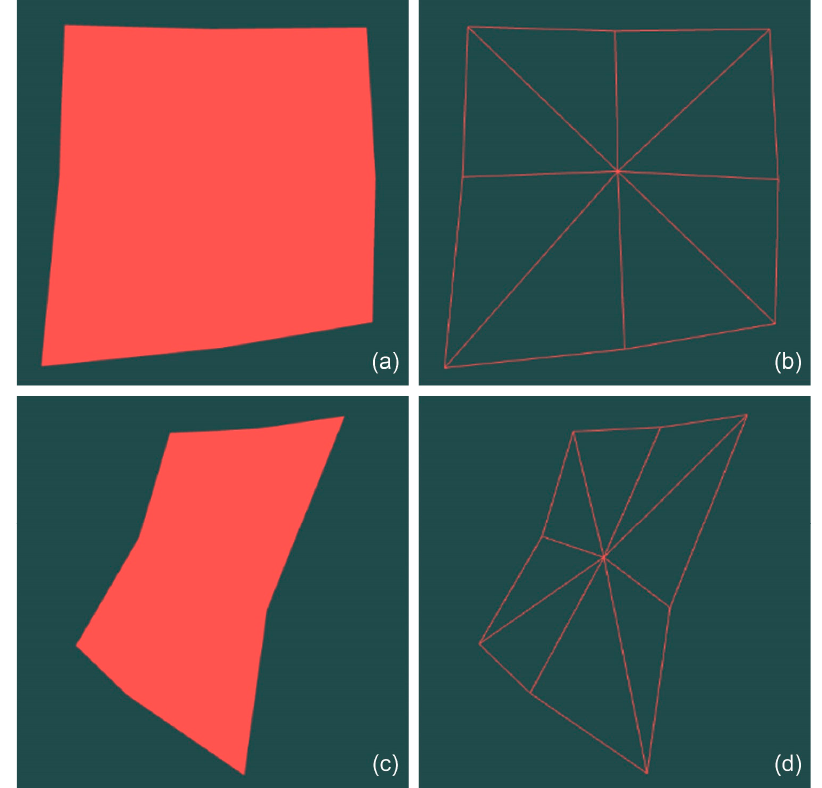
Figure 6. Modeling effect: ( a ) effect of a single frame of the front view model, ( b ) effect of a single frame of the elevation point model, ( c ) effect of a single frame of the side view model, and ( d ) effect of a single frame of the side viewpoint model.